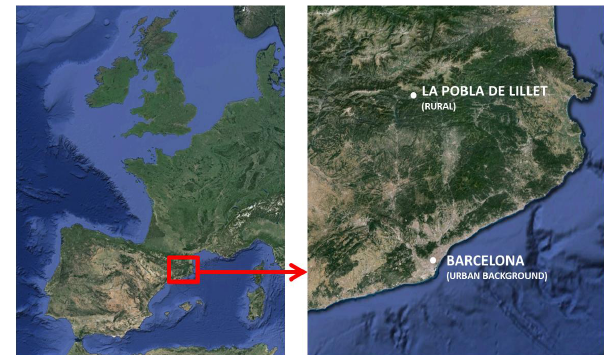
Figure 1. Location of the urban background sampling site in Barcelona and the rural sampling site in La Pobla de Lillet in the